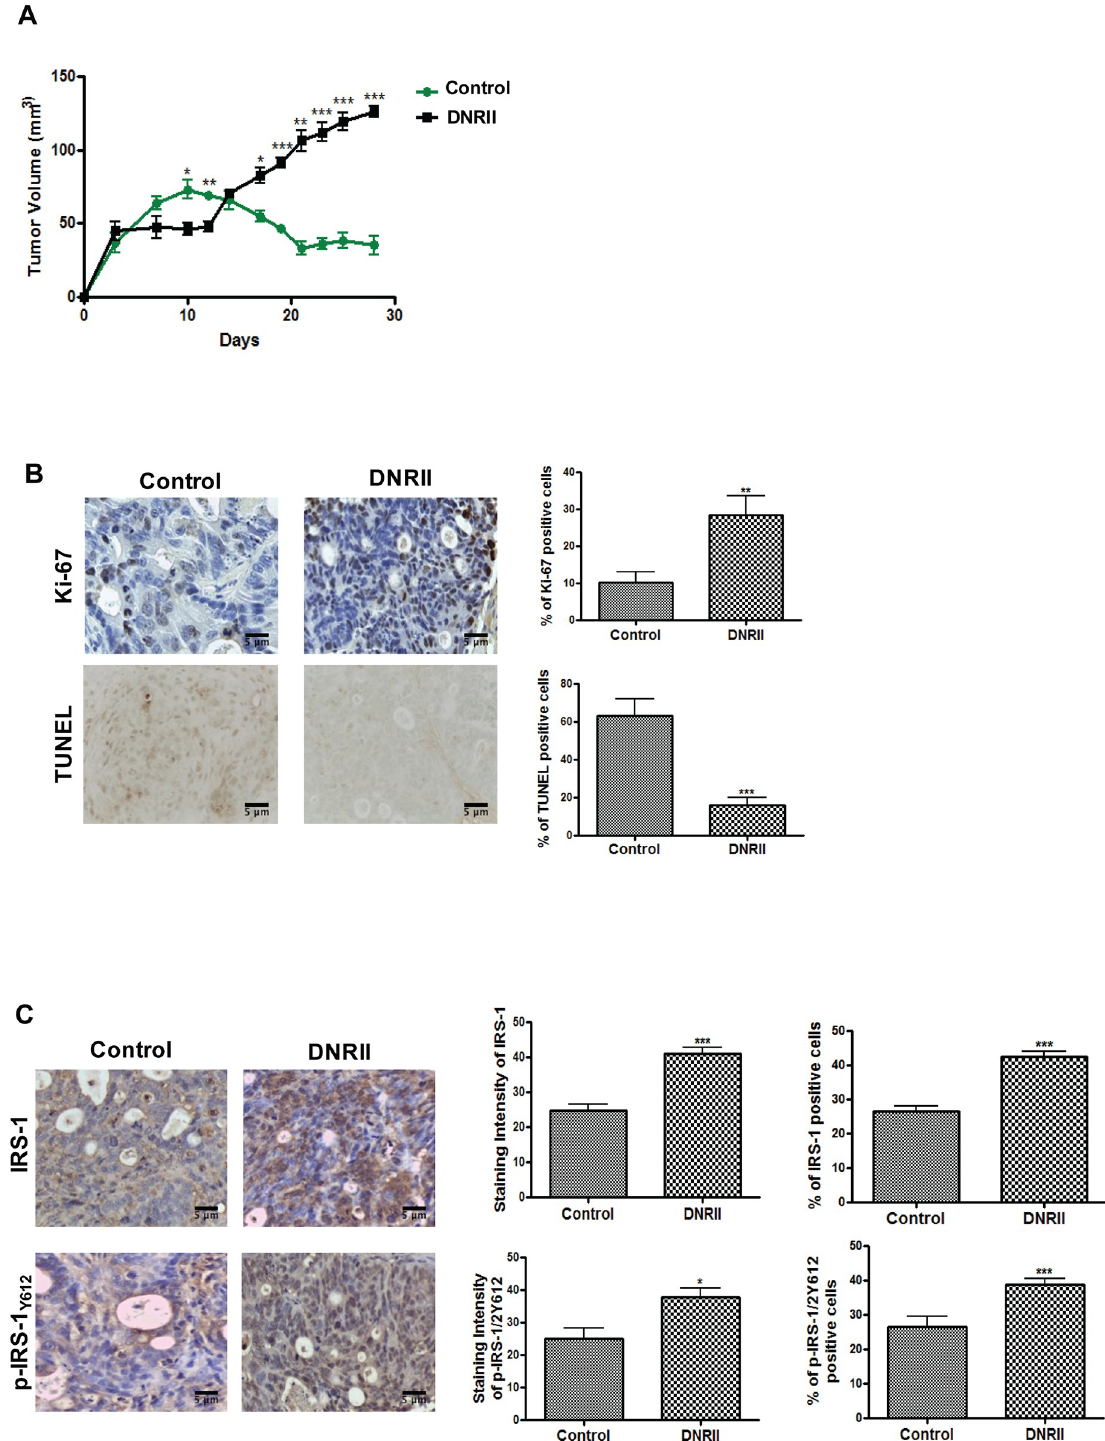
Fig 1. Abrogation of TGF β signaling led to increased expression and activation of IRS-1 in colon cancer cells in vivo . (A) Xenograft tumor growth curves of FET control and DNRII cells are shown. n = 10. ( B) Representative images of Ki67 and TUNEL staining are shown (left). Percentage of positive staining cells was determined(right). (C) Representative images of IRS- 1 and pIRS1Y612 stainingin xenograft tumors are shown (left). Quantification of staining intensity and percentageof positive cells was performed (right). Scale bars, 5 μ m. The data are presentedas the mean ± SD. * P < 0.05, ** P < 0.01, *** P < 0.001.